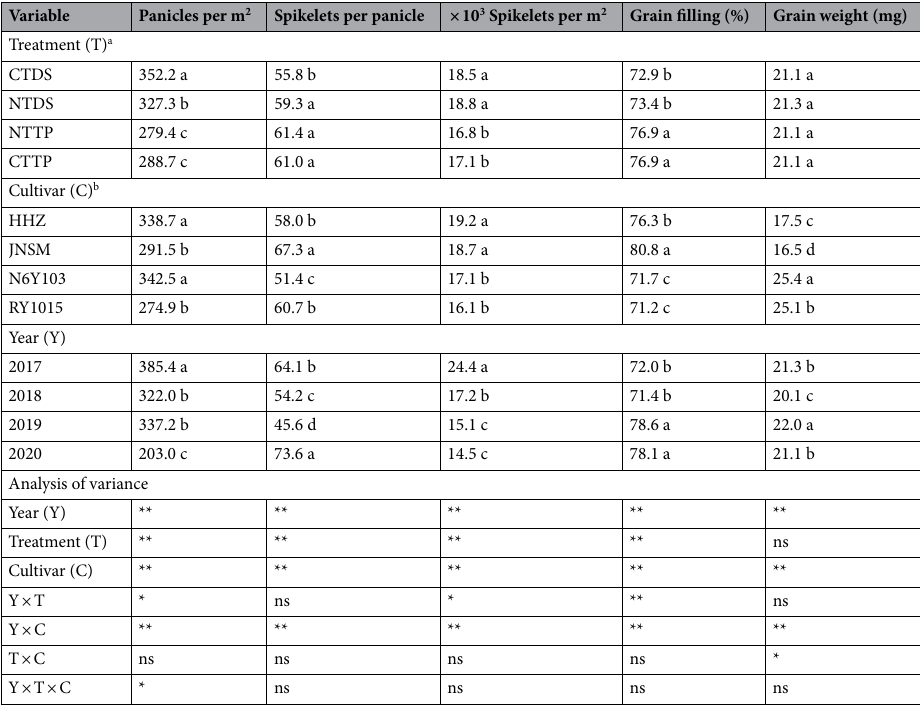
Table 5. Yield components of four rice cultivars grown under four cultivation methods in the ratoon rice season in 2017–2020. a CTDS, NTDS, NTTP and CTTP represent conventional tillage and direct seeding, no-tillage and direct seeding, no-tillage and transplanting and conventional tillage and transplanting respectively. b HHZ, JNSM, NY103 and RY015 are Huanghuazhan, Jinnongsimiao, Nei6you103 and Rongyou1015, respectively. Means within each variable sharing the same letter are not significantly different according to LSD at P = 0.05. *Significant at P < 0.05, **Significant at P < 0.01, ns, not significant at P <